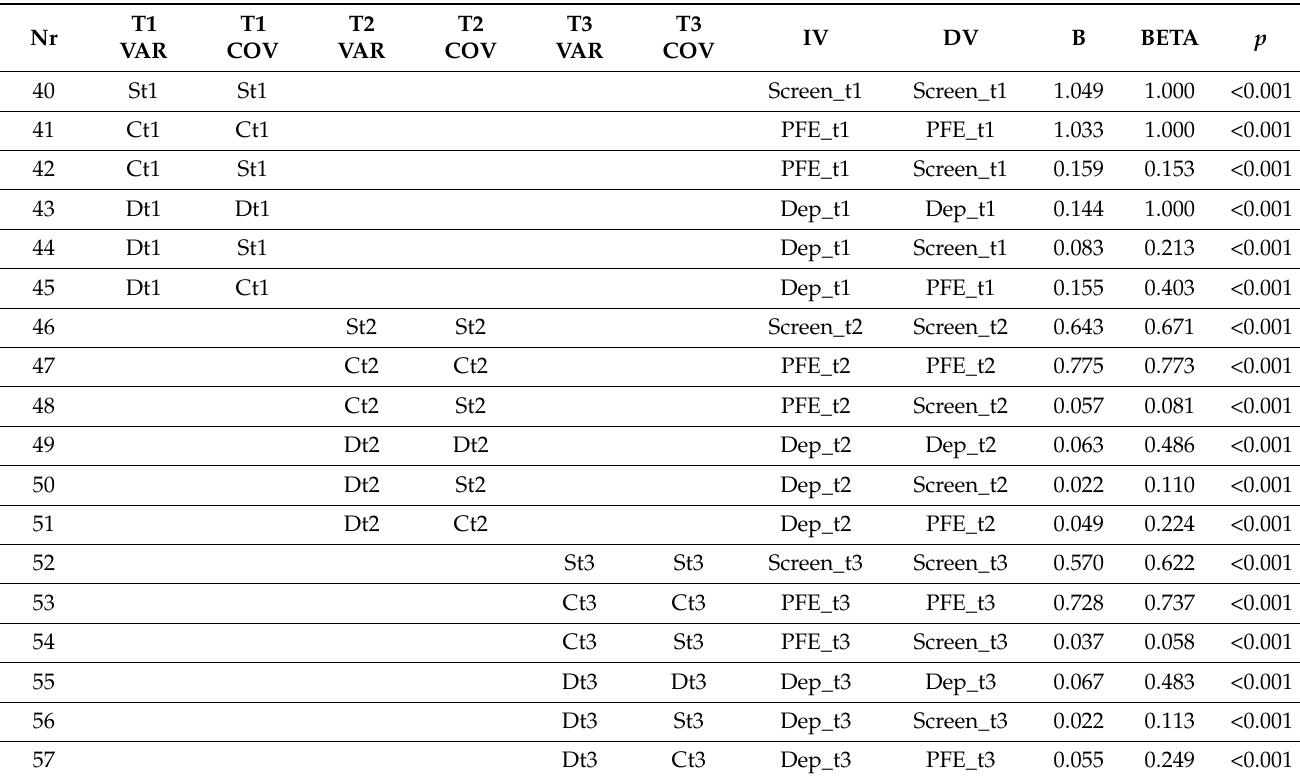
Table A5. Model estimates from the structural regression (pathway) analysis results: variances and covariance